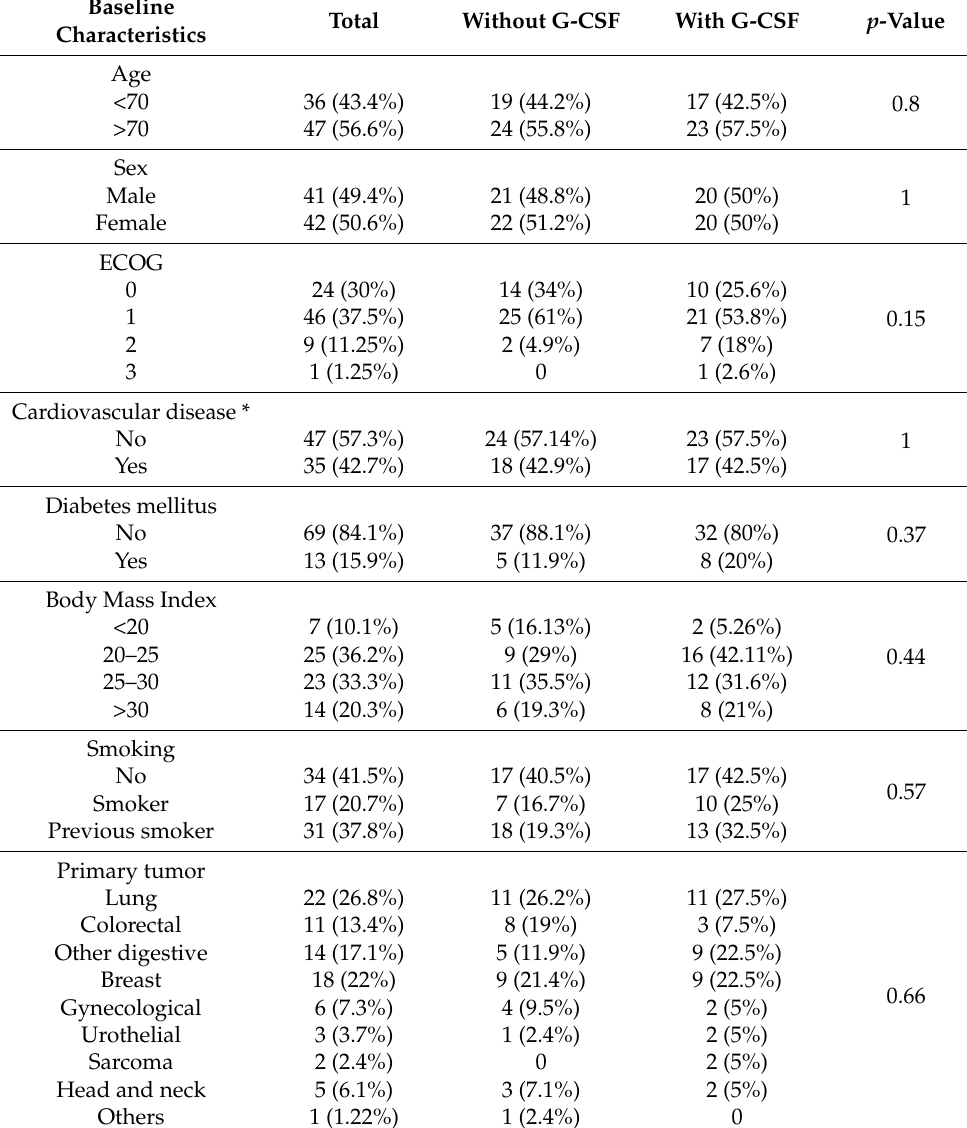
Table 1. Baseline characteristics of all patients included: total and split by G-CSF treatment. No attempt was made to impute missing values present in some variables. The p -value of association with G-CSF is also